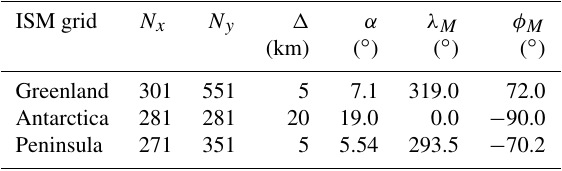
Table 2. The grid sizes N x , N y and the grid resolution (cid:49) of the three ISM grids that result from the mapping applications in Sect. 4.2, us- ing the oblique SG projection for the sphere or the WGS84 ellipsoid with the projection parameters α and the coordinates of the projec- tion centre ( λ M , φ M